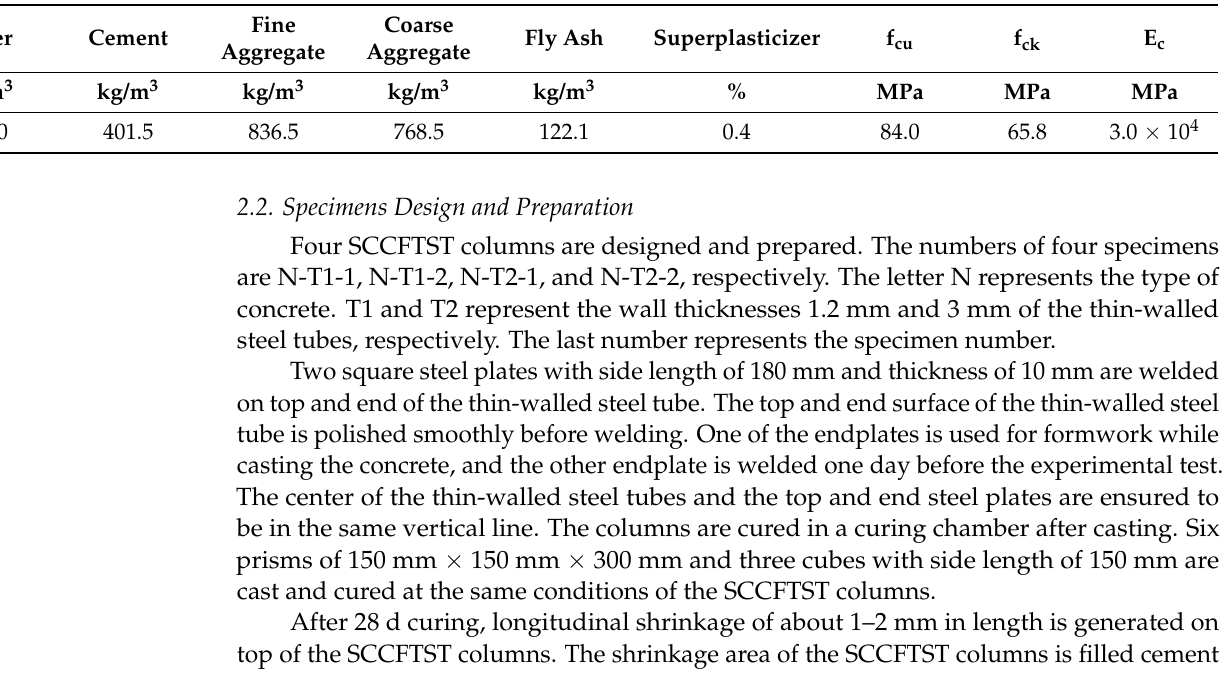
Table 2. Mix proportion and mechanical performances of the self-compacting